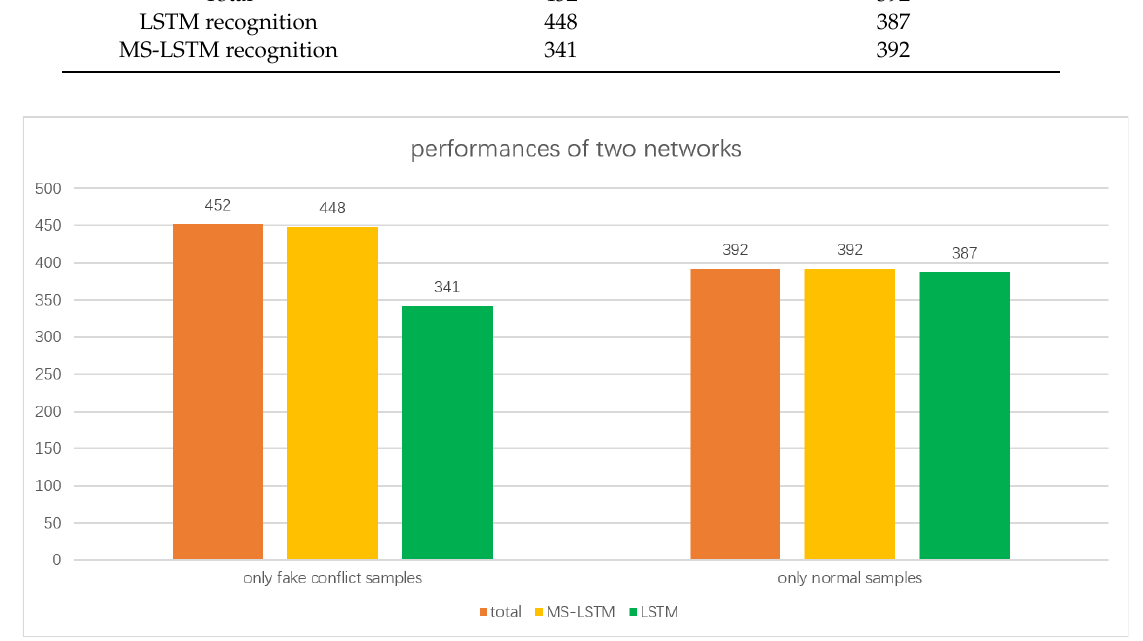
Figure 9. Validation performance when the network only uses fake conflict samples or normal samples. This figure demonstrates total number of two kinds of samples and the recognition number of network.